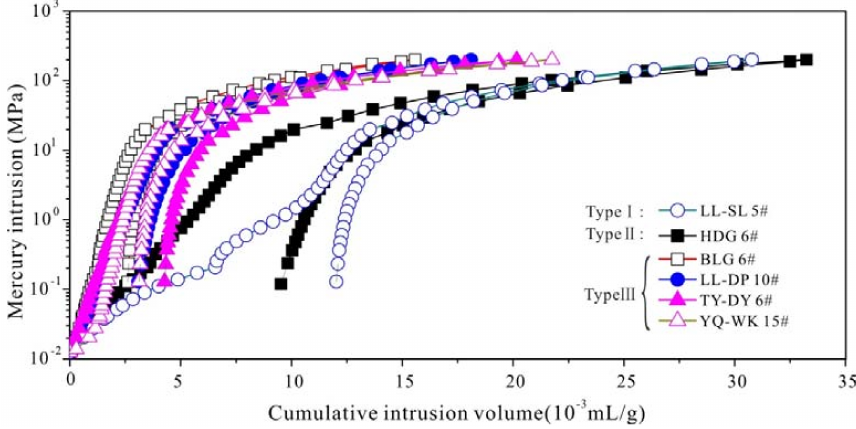
Figure 2. Cumulative intrusion volume vs. intrusion pressure for six coal samples with different coal